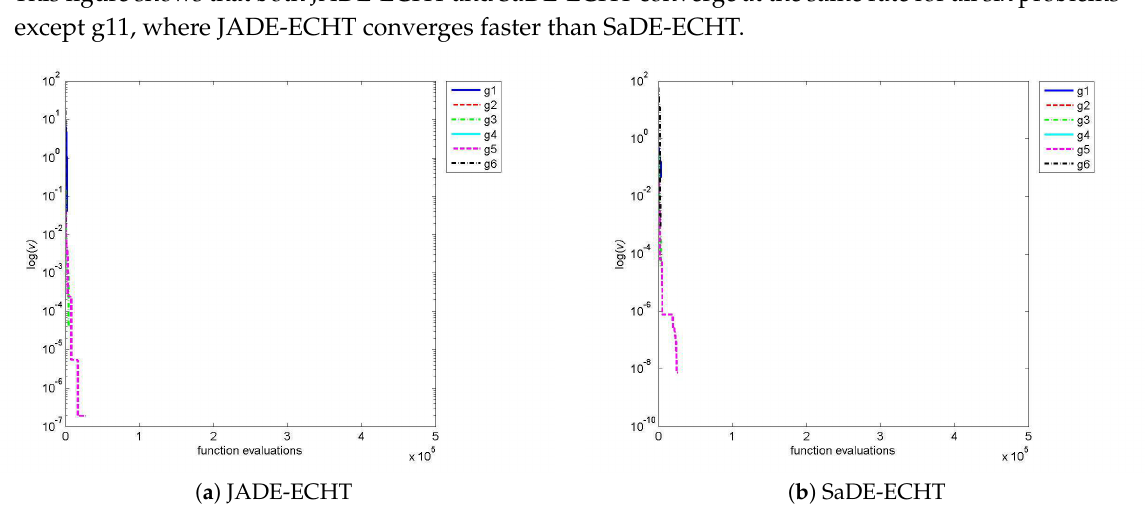
Figure 4. Constraint violation comparison of JADE-ECHT and self-adaptive differential evolution (SaDE)-ECHT for g01–g06.